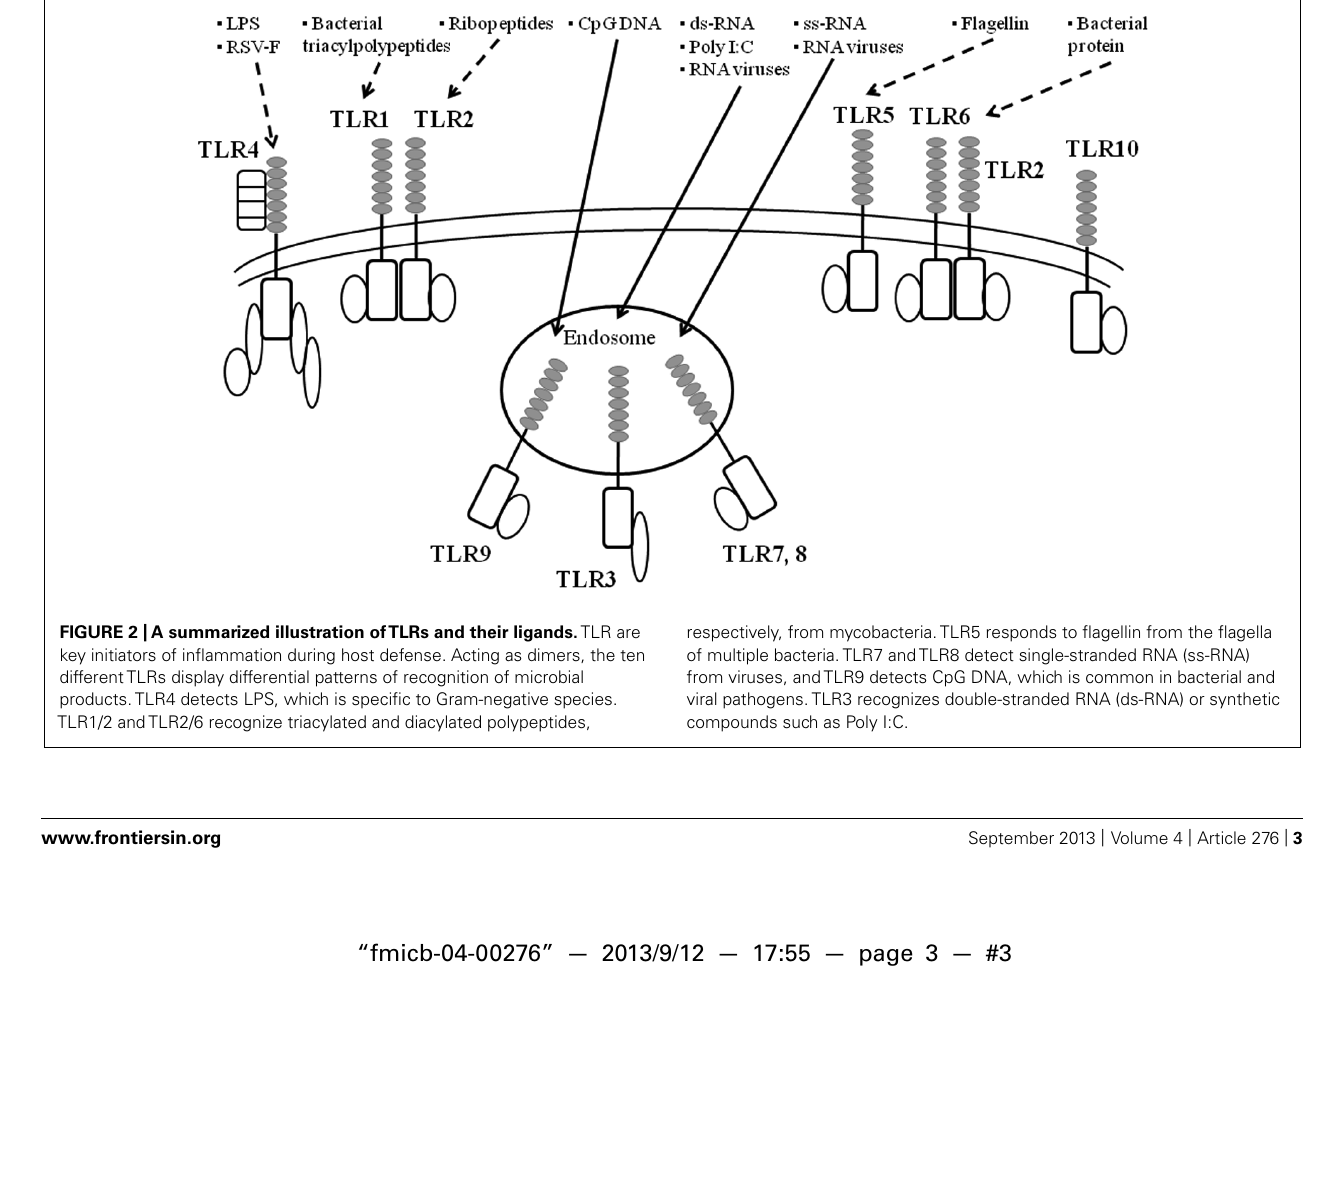
FIGURE 2 |A summarized illustration ofTLRs and their ligands. TLR are key initiators of inflammation during host defense. Acting as dimers, the ten differentTLRs display differential patterns of recognition of microbial products.TLR4 detects LPS, which is specific to Gram-negative species. TLR1/2 andTLR2/6 recognize triacylated and diacylated polypeptides,